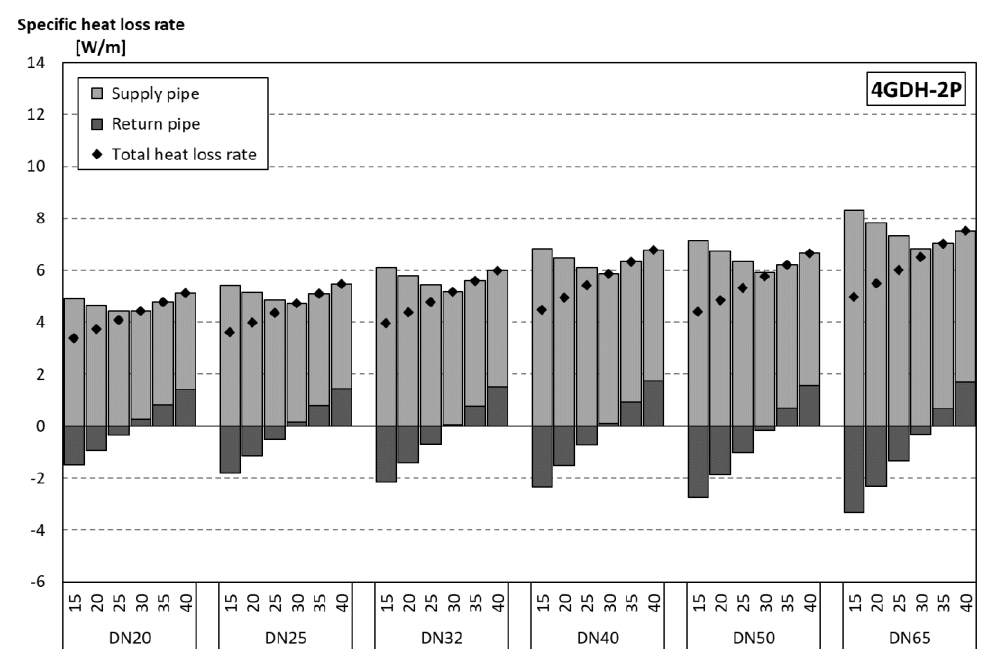
Figure 3. Specific heat loss rates [W/m] of supply (54 °C) and return (15 – 40 °C) at different pipe dimensions (DN20-DN65) for three insulation series, according to [17].